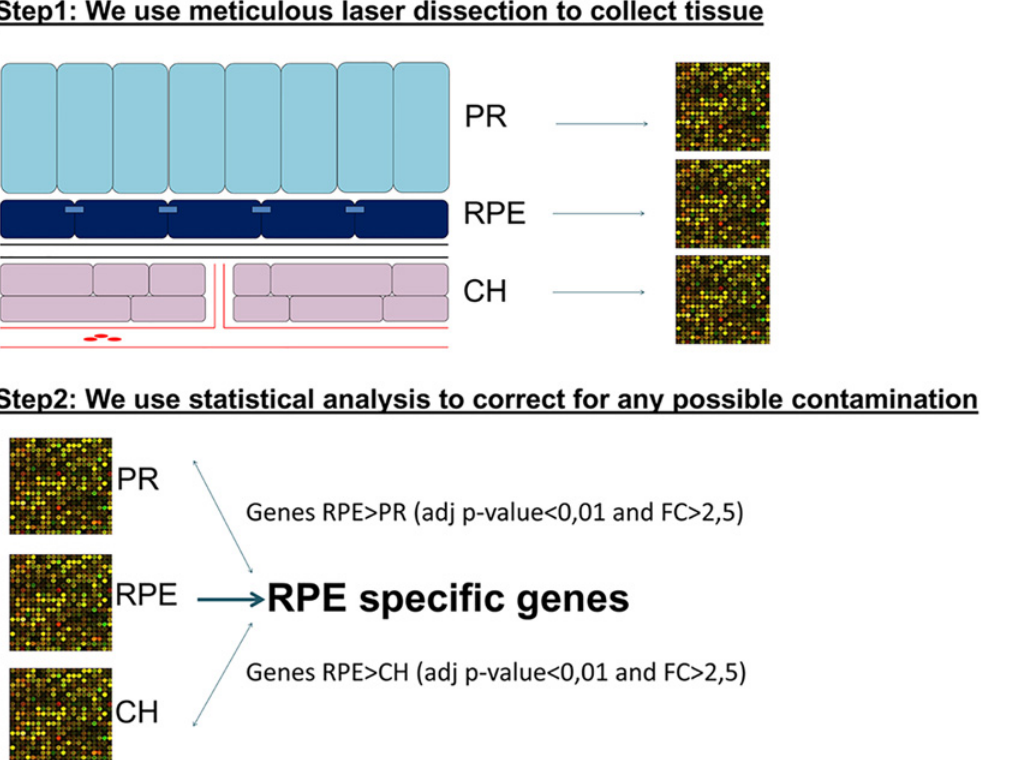
Fig 2. Strategy to select RPE signature genes. In the first step of this strategy we laser dissect the RPE (and its adjacent layers, the CH and PR) for specific tissue collection. In the second step we statistically correct for possible contamination by adjacent